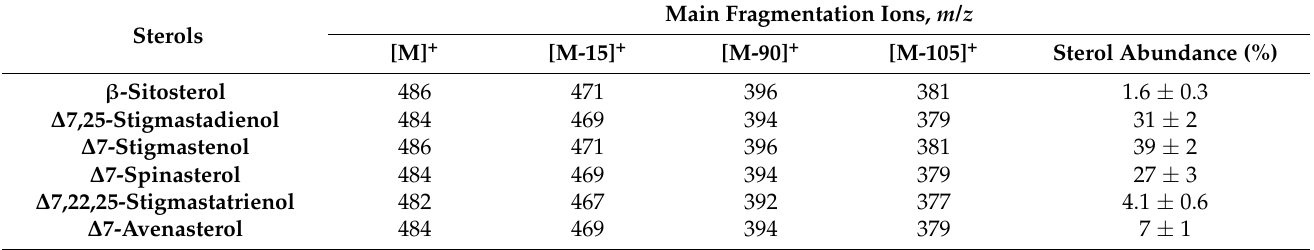
Figure 2. Total ion current and peak attributions of unsaponifiable fraction of Cp_sc-CO 2 . Table 3. Fragmentation ions used for identification of sterol trimethylsilyl ethers. [M + ] molecular ion and [M − 15] + loss of the methyl terminal group; [M − 90] + corresponding to [M-(CH 3 ) 3 SiOH] + ; [M-105] + corresponding to [M-(CH 3 ) 3 SiOH-CH 3 ] +